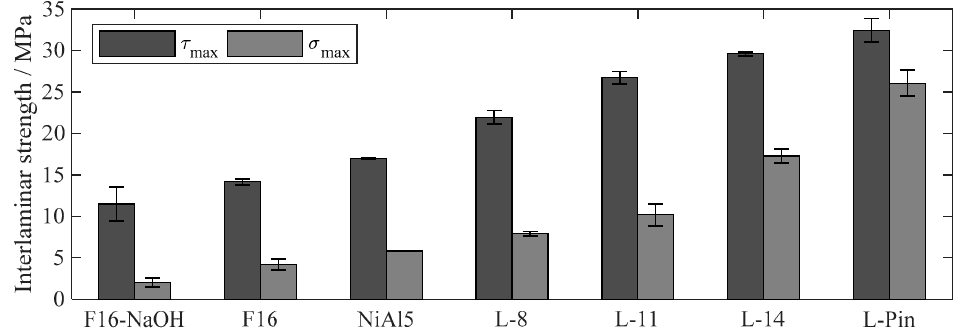
± 1 SD. Materials 2020 , 13 , x FOR PEER REVIEW